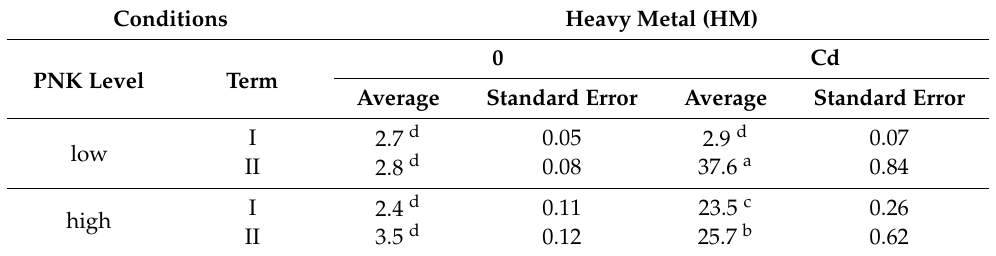
Table 1. The concentration of cadmium in water [µgCd · dm −3 ] in the three tested growing seasons. Conditions PNK Level